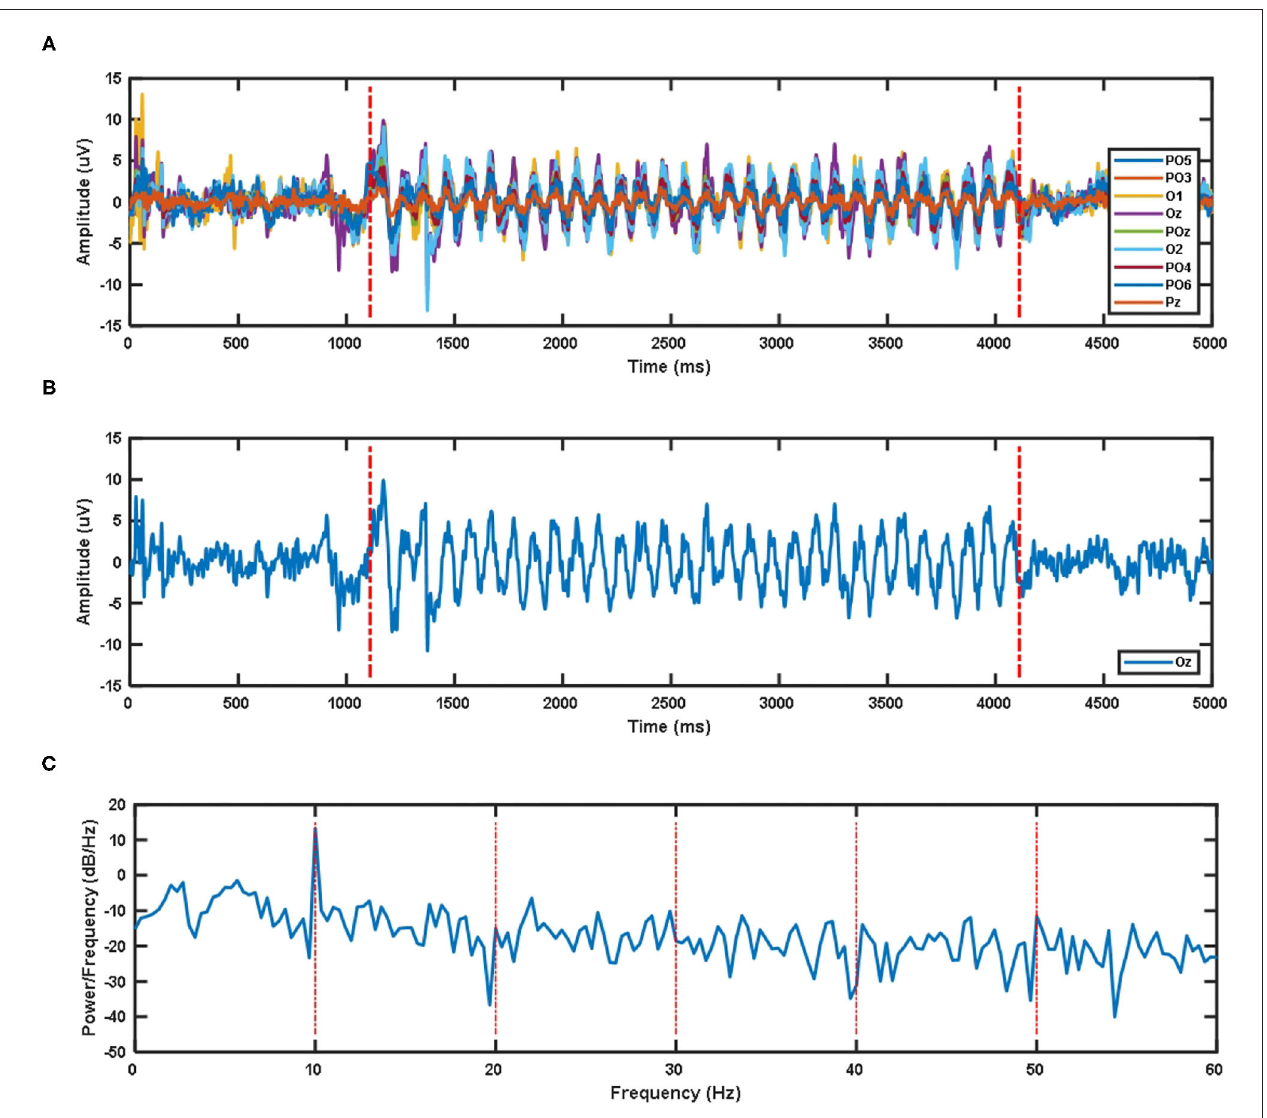
FIGURE 2 | (A) The superposition average of time domain waveforms of nine electrode channels at 10 Hz visual stimulation frequency for all subjects. (B) Superposition average of time domain waveform of Oz electrode channel at 10 Hz visual stimulation frequency for all subjects. (C) Superposition average of PSD of Oz electrode channel at 10 Hz visual stimulation frequency for all